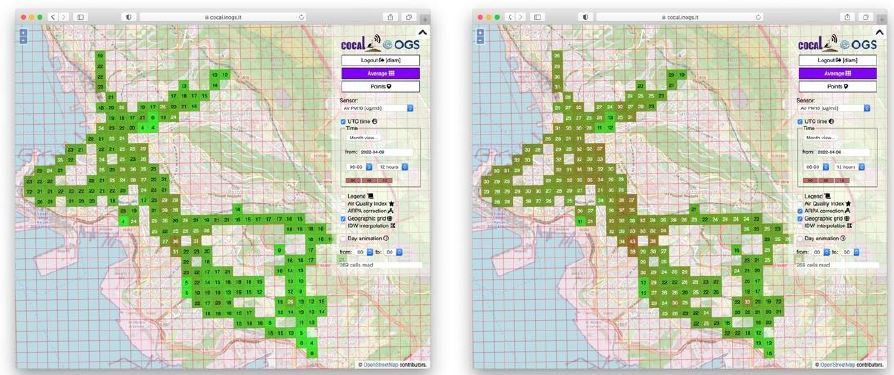
Figure 2. Averaged PM10 distribution ( left ) and reference corrected distribution ( right ).